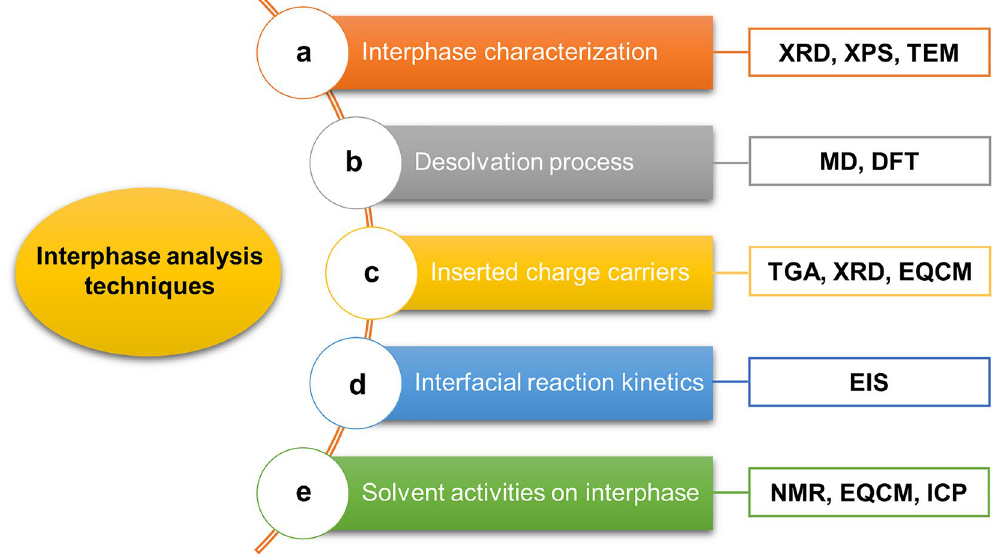
Fig. 4 Characterization techniques, electrochemical measurements, and computational simulations for the analysis of electrolyte–electrode